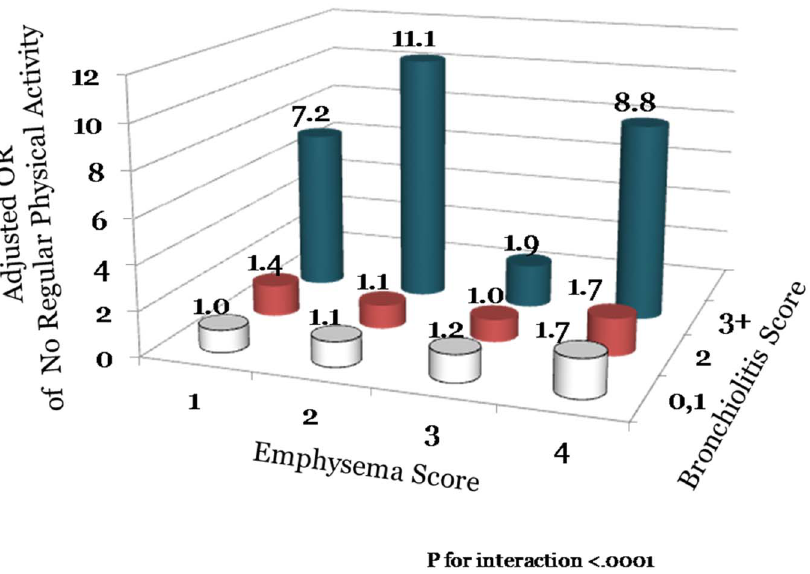
Figure 3. The Synergistic Interaction of Emphysema with Bronchiolitis Scores on The Risk of Reduced Regular Physical Activity.